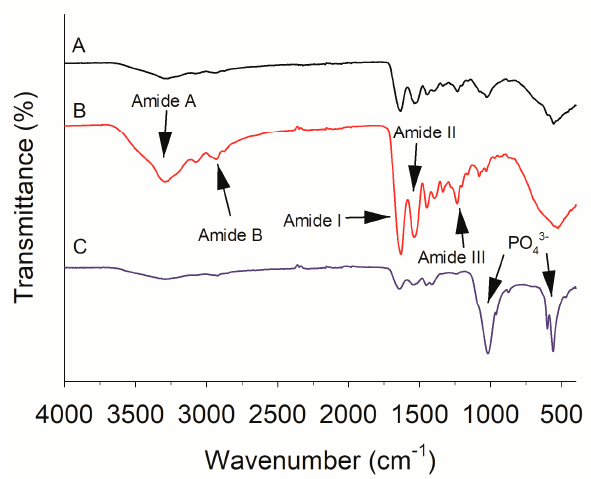
Figure 2. Fourier transform infrared spectra of fish scale under different pretreatment: untreated scales ( A ), tilapia scale protein powder ( B ), scale residues after hydrothermal treatment ( C ).